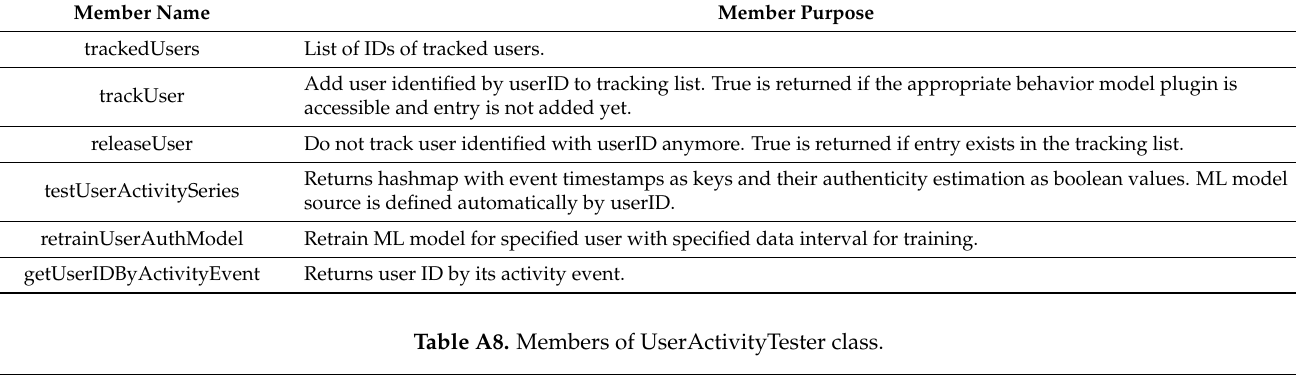
Table A7. Members of AuthenticityCheckingProvider class.